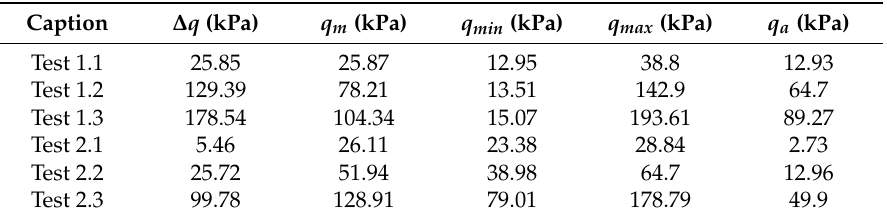
Figure 1. Stress parameters for a constant amplitude of loading for the tested recycled concrete aggregate (RCA). q a , stress amplitude; q m , average stress; Δ q , stress difference; q max , maximal stress; q min , minimal stress. Table 1. The stress parameters for the S-N curve for the tested RCA.